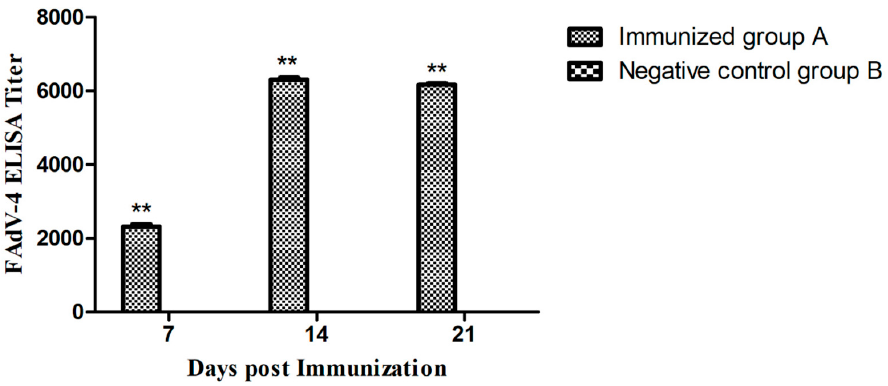
Figure 7. FAdV-4 specific antibody responses induced at 7, 14, and 21 days post-immunization.